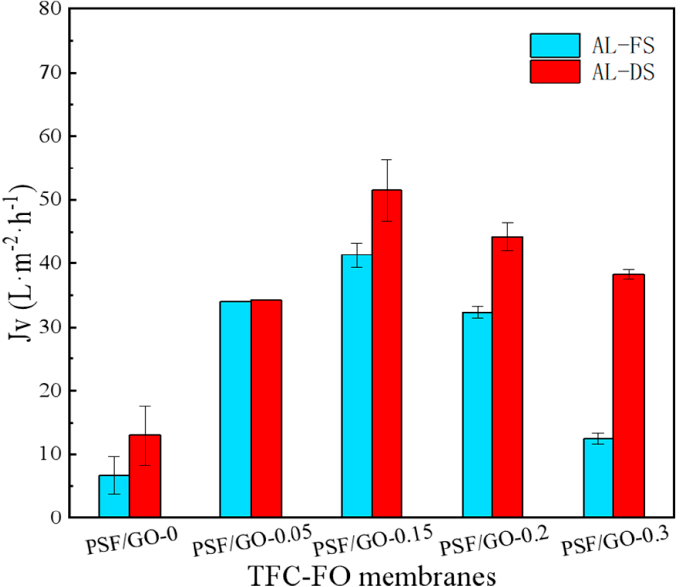
Figure 6. Water flux analyses in the AL-DS and AL-FS modes for TFC-FO PSF/GO membranes.